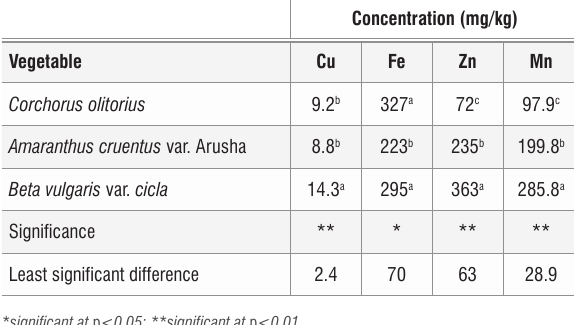
The main effect of vegetable plant species on leaf concen- trations of Cu, Fe, Zn and Mn